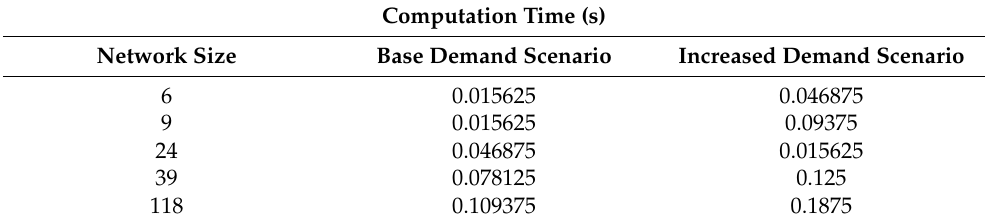
Figure 10. The per unit cost of relaxing the constraint in base and increased demand scenarios in the 118-bus system. Table 14. The comparison of the computation times of the 5 different network